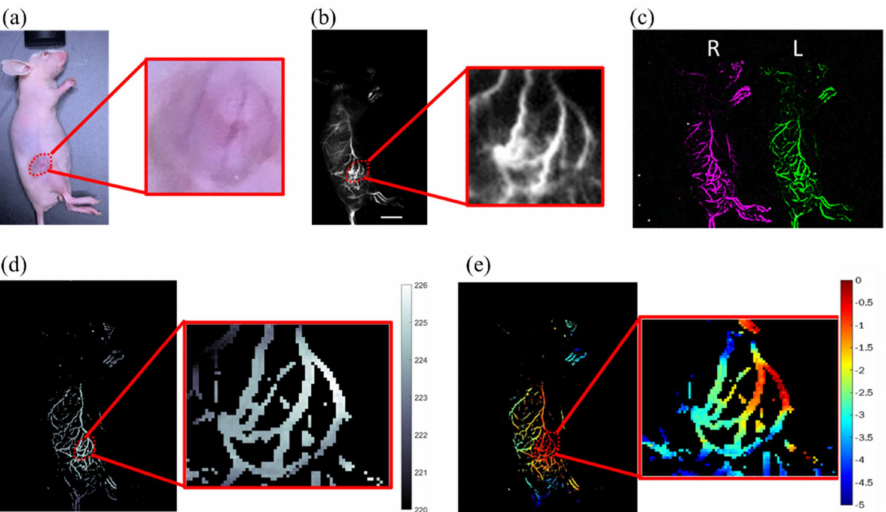
Figure 7. Results of in vivo blood vessel of tumor-bearing mice after intravenous injection of IR-TPE Pdots (inset: enlarged tumor region): ( a ) ambient image and ( b ) NIR-II fluorescence image (scale bar, 10 mm), ( c ) enhanced left- and right-vessel images, ( d ) disparity map of nude mice, and ( e ) depth map of nude mice with 6 mm